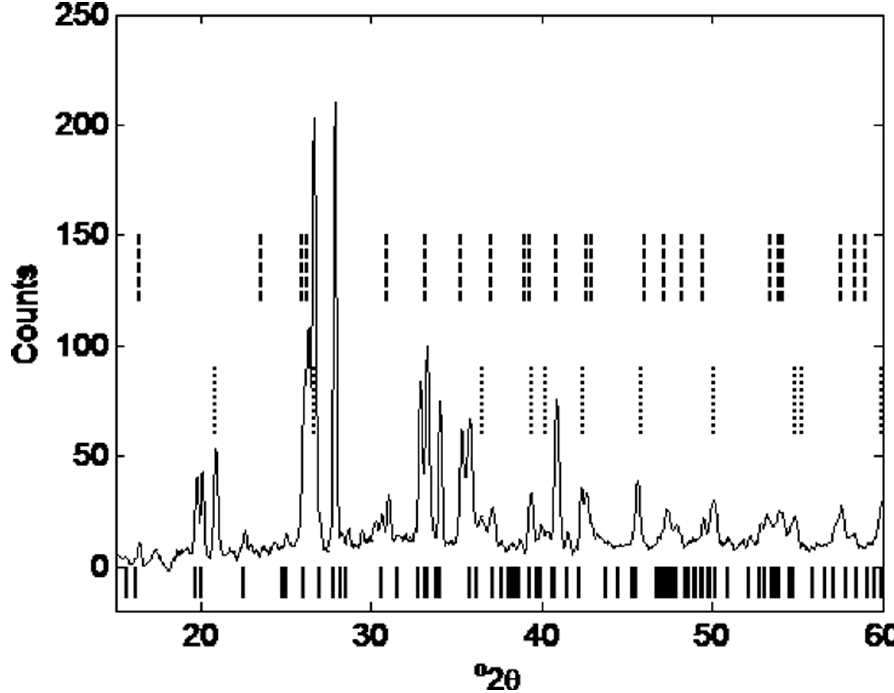
Figure 14. XRD pattern of a geopolymer sample containing efflorescence crystals on the surface: solid black lines below the pattern are gaylussite (Na 2 Ca(CO 3 ) 2 · 5H 2 O), dotted lines are quartz and dashed lines are mullite.